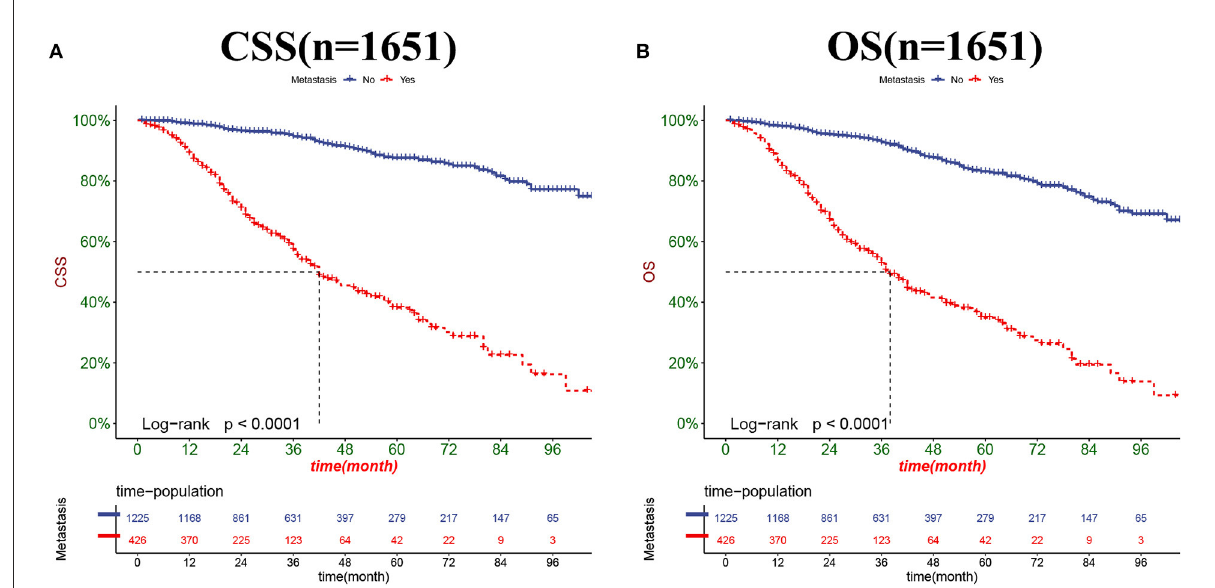
FIGURE9 Kaplan-Meier curves for predicting CSS (A) and OS (B) in PC patients with distant metastases.